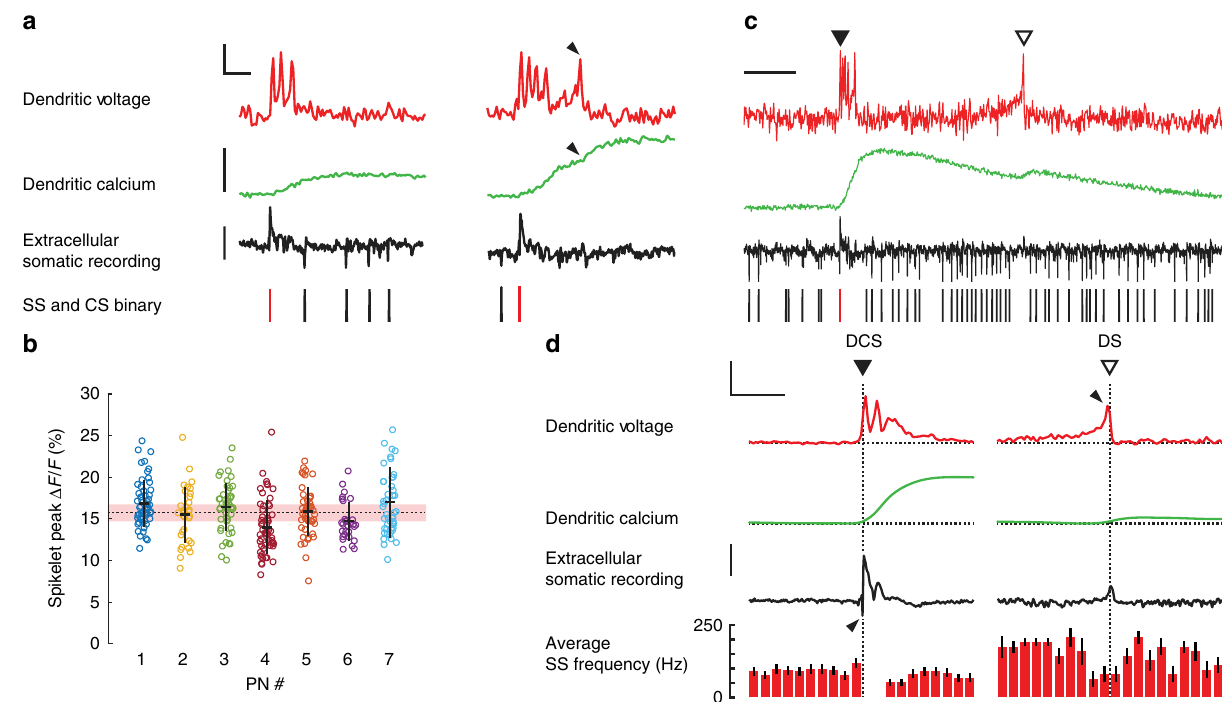
Fig. 2 Two types of rapid and variable suprathreshold signals detected in spiny dendrites of awake mice. a Examples of dendritic complex spike (DCS) events (selected from Fig.1f) showing voltage (top red traces; vertical scale bar 10% Δ F / F , corresponding to about 21 mV; horizontal scale bar 5 ms), calcium (middle green traces; vertical scale bar 40% Δ F / F ), and the corresponding extracellular somatic recording (bottom black trace; vertical scale bar 100 pA). Somatic binary signal showing SSs (black bars) and CSs (red bars). Black arrows indicate a late spikelet and a corresponding increment in calcium. b Amplitudes of the initial spikelets from all DCS recorded from 7 PNs (318 DCS in total), mean ± s.d. shown for each PN, group mean shown by dashed line and the pink bar shows error due to shot noise. c An example of a single dendritic spike (DS) event (open triangle) following a DCS event. Scale bar 50 ms. d Average dendritic voltage (vertical scale bar 10% Δ F / F ; horizontal scale bar 25 ms), calcium (vertical scale bar 20% Δ F / F ) and extracellular somatic recording (vertical scale bar 50 pA), and SS frequency (in 5 ms bins) from 49 DCS events (left) and 13 DS events (right) recorded from the same PN.